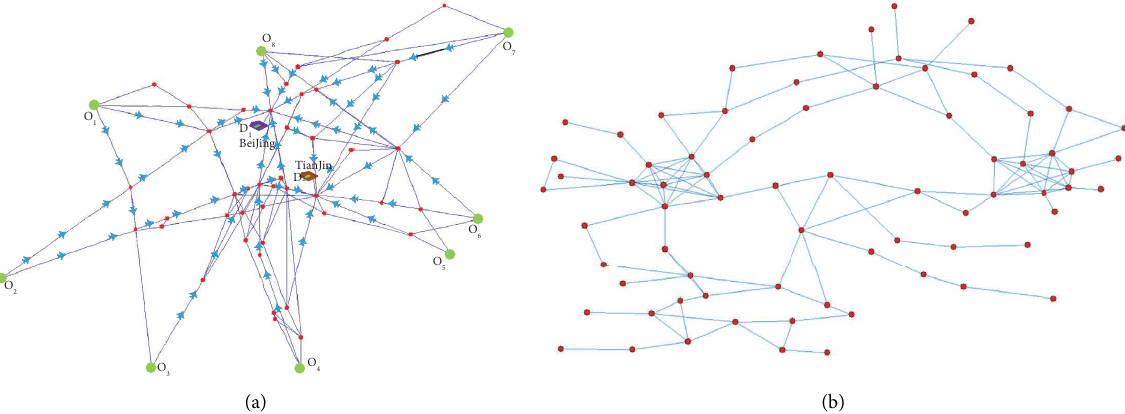
Figure 9: Te ASTN model of BCA. (a) Te distribution of aircraft in the BCA. (b) Aircraft state network.